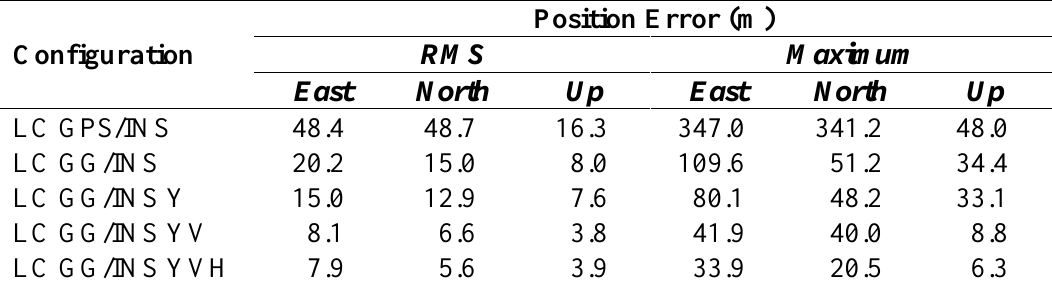
Table 5. Position error obtained with LC